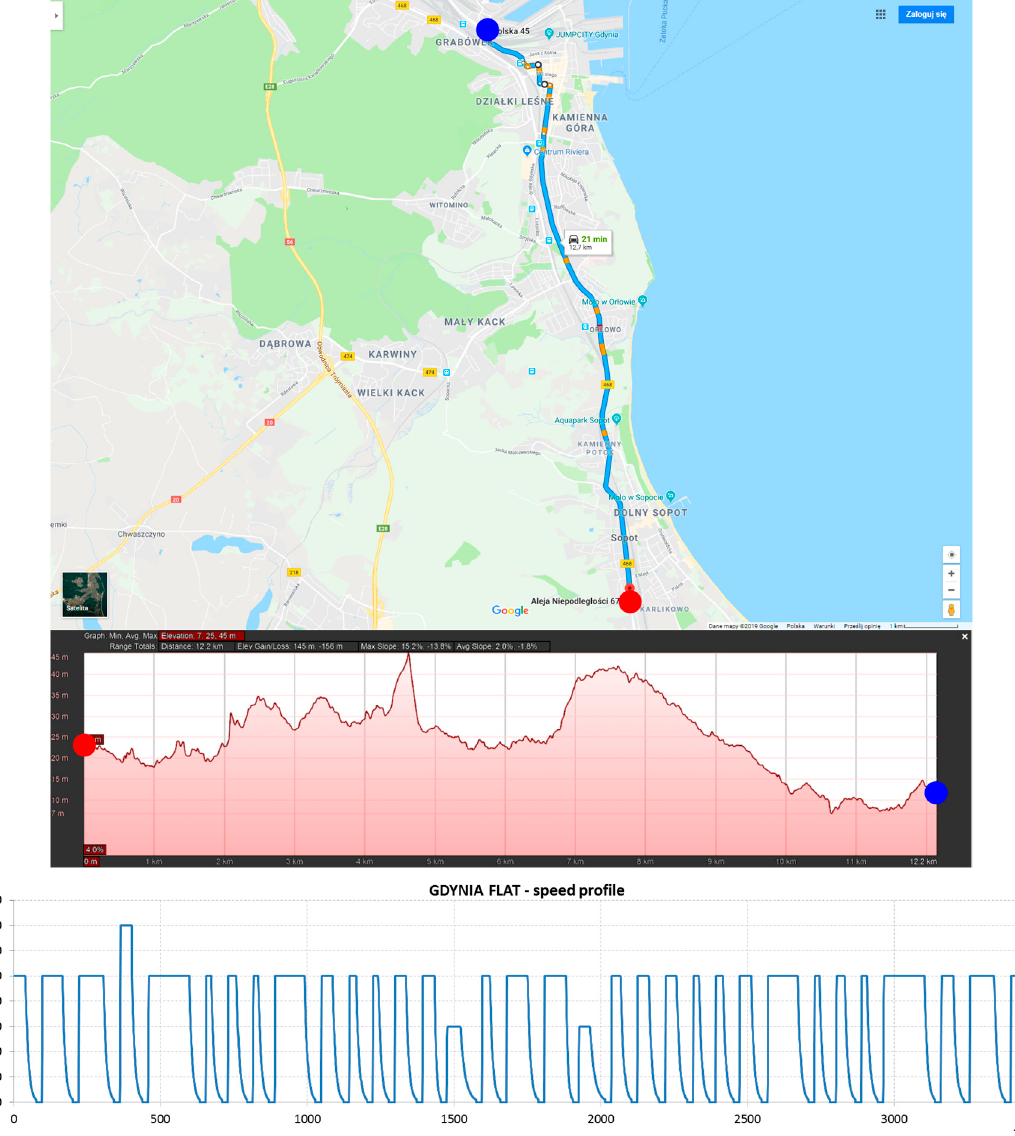
Figure 22. Gdynia-Flat route height and speed profiles. Map data from Google Maps.